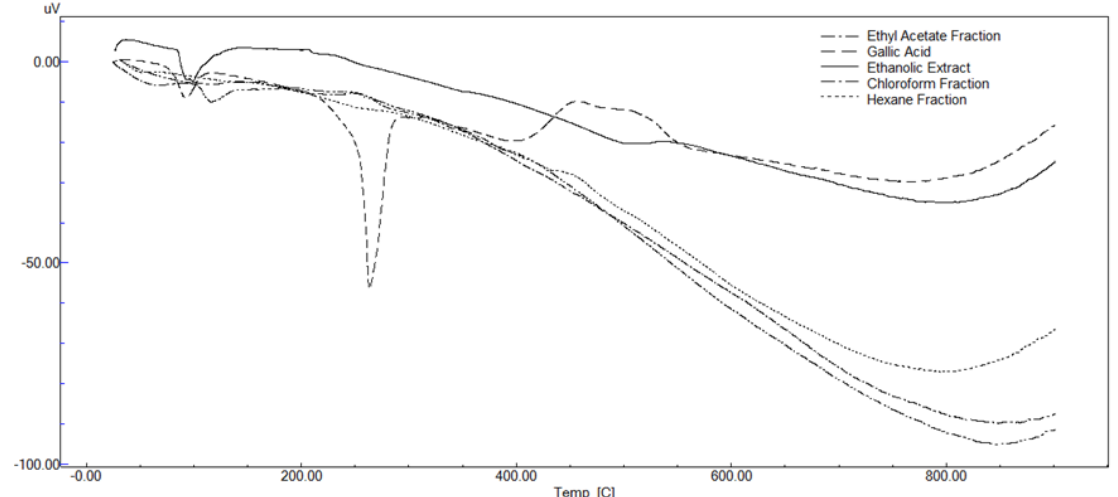
Figure 3. DTA curve of gallic acid and the samples produced from the extract of S . brasiliensis Engl. Table III. Data from TG curves of the extract and fractions S. brasiliensis Engl.